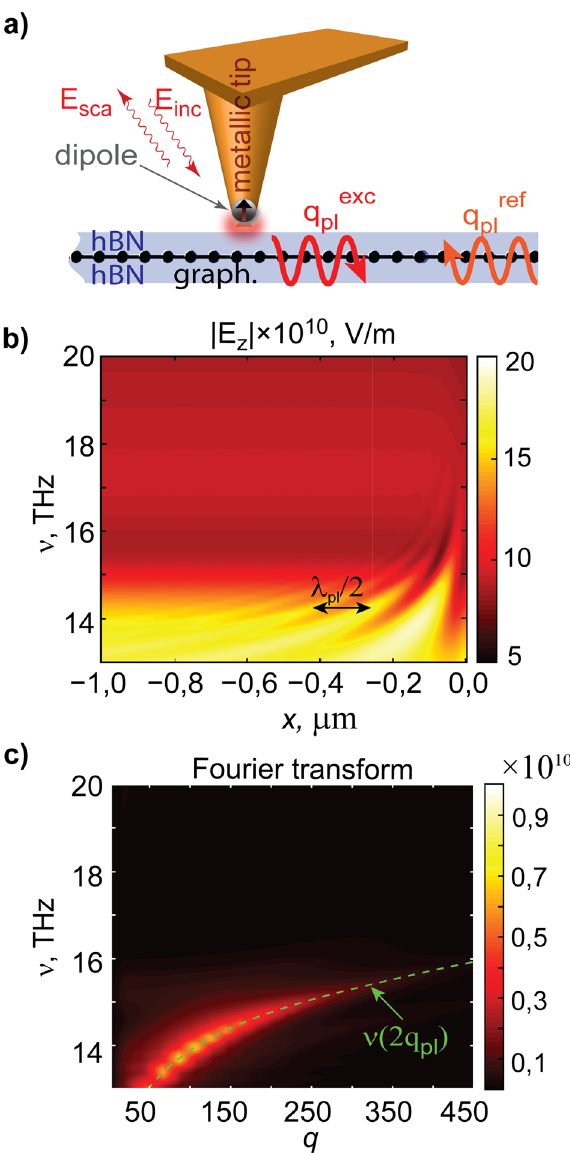
Fig. 4 Simulation of the near- fi eld experiment. a Illustration of the simulation model: the atomic force microscope tip is approximated by a vertical electric dipole with a constant dipole moment. The dipole is located 55 nm above the charge neutral graphene encapsulated into hBN (the thicknesses of the top and bottom layers are 5 nm and 10 nm, respectively). b Near- fi eld image | E z ( x , v )| simulated for magnetic fi eld B = 1.3 T . The fi eld E z is taken below the dipole, 10 nm above the graphene sheet. c Fourier transform of | E z ( x , v )|. The bright feature matches v (2 q pl ) what re fl ects the fact that the graphene plasmon-polariton between being excited, re fl ected and gathered by the tip travelling the distance 2x .